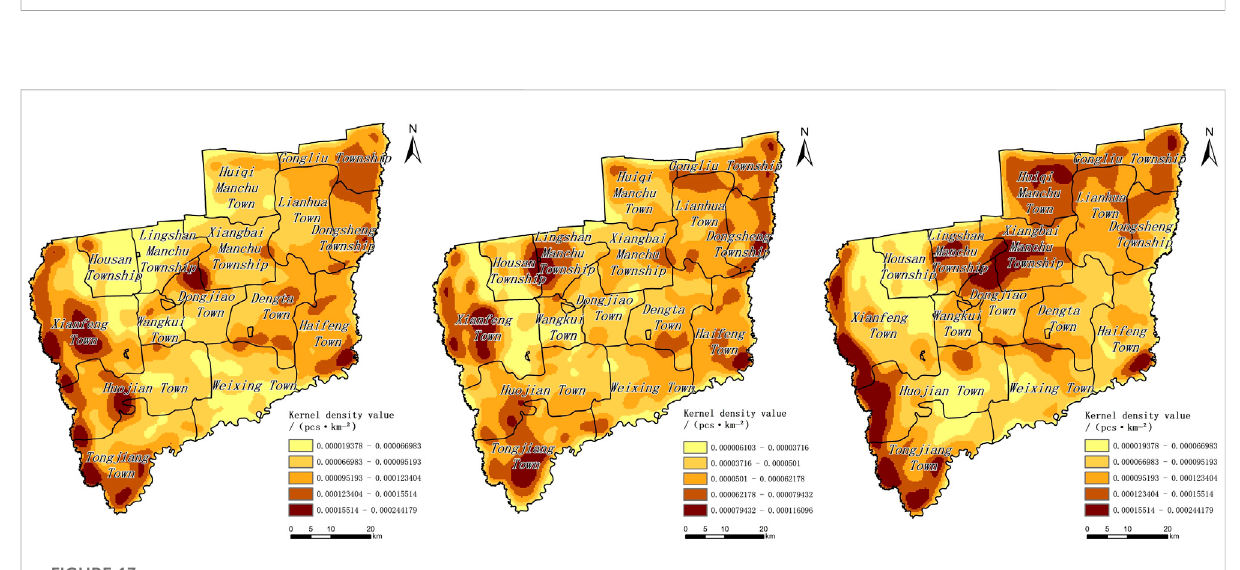
FIGURE 13 Spatial distribution characteristics and evolution of mixed-cropping